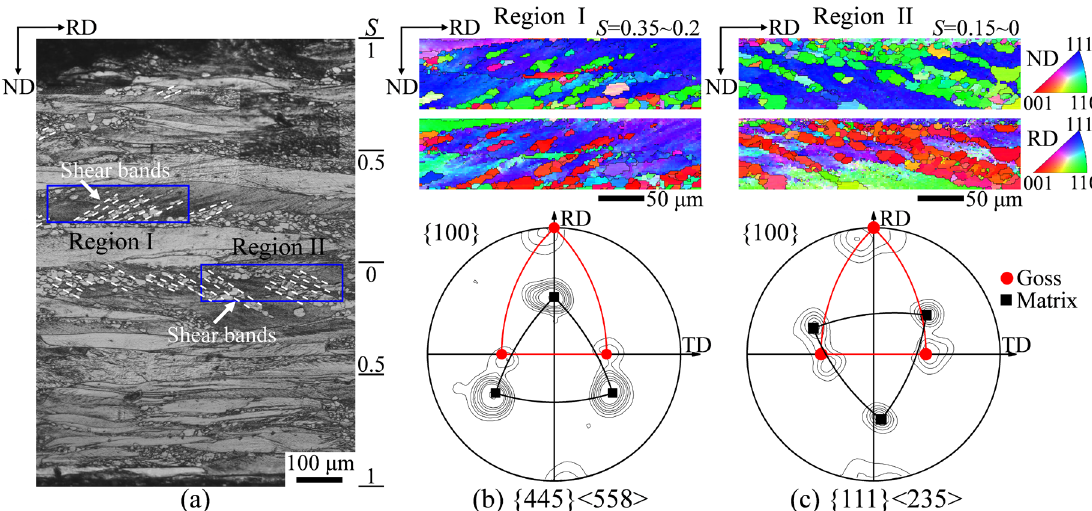
Figure 6. (a) Microstructure and (b, c) local enlarged orientation image maps marked in Figure 6(a) and corresponding {100} pole figures of recrystallized grains and correspondingly surrounded deformed matrices for Goss nucleation sites in 10% recrystallized Fe-2.1 wt.% Si